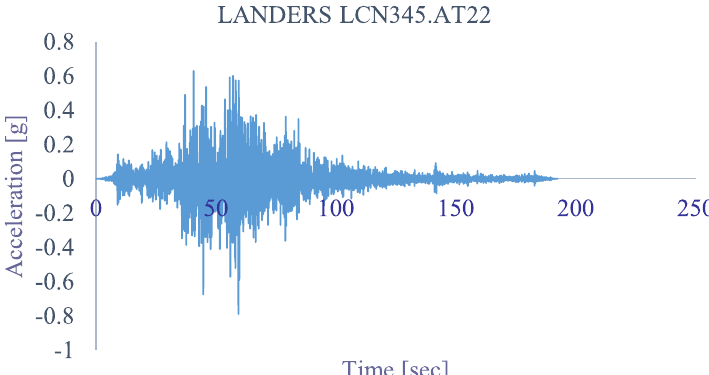
Fig. 11 The other record of the horizontal component (LCN345) of the Landers